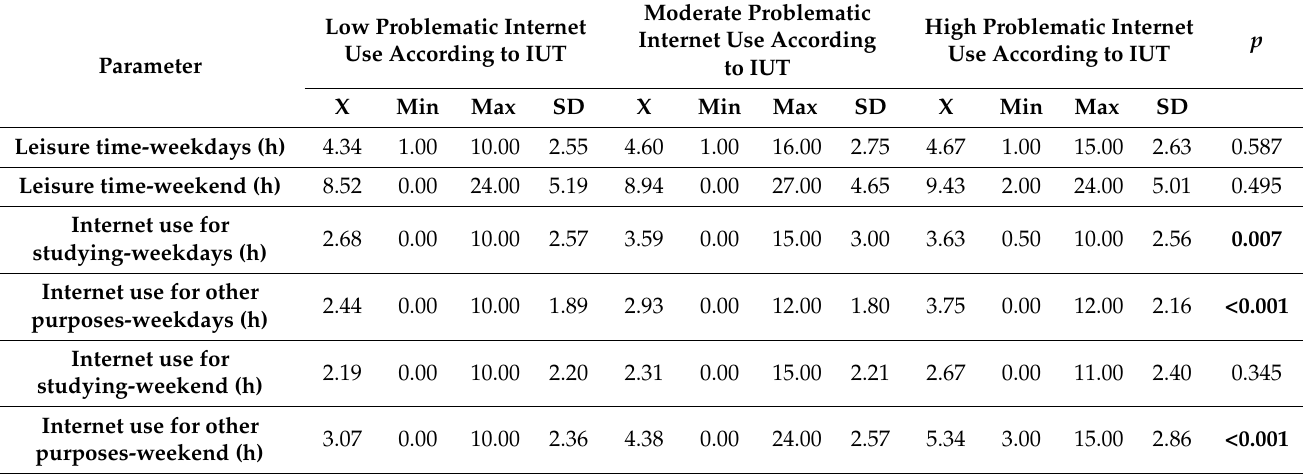
Table 1. Number of hours spent online for various purposes according to the Internet Use Test